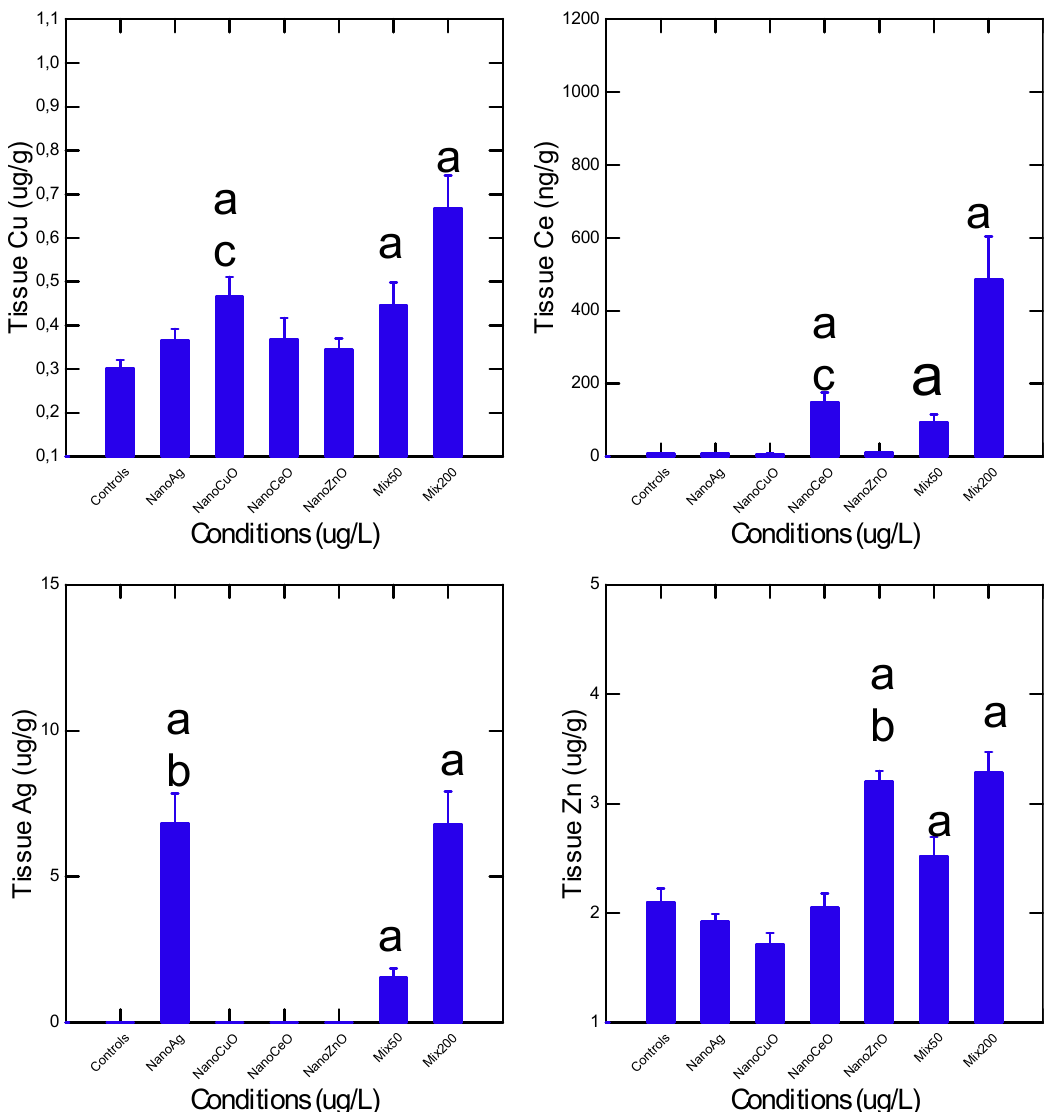
Figure 1. Bioavailaibility of inorganic nanoparticles alone and in mixtures. Mussels tissues were analyzed for Ag, Ce, Cu and Zn levels following a 12 h depuration step in clean aquarium water. The data represent the mean with the standard deviation. The letters a denotes a significant difference to controls, the letter b denotes significant effect from the Mix50, and c denotes significant difference from Mix200.